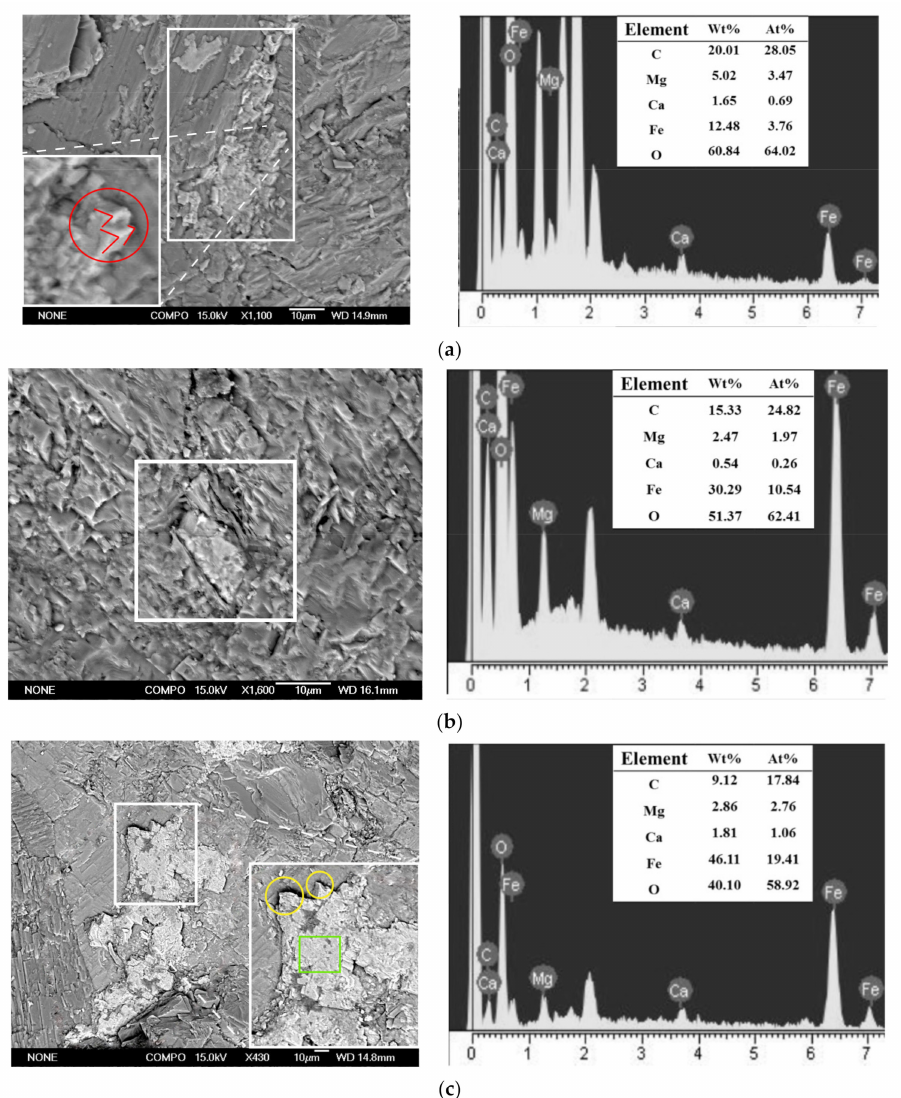
Figure 5. Authigenic carbonates formed after the experiment. ( a ) Carbonates A. ( b ) Carbonates B. ( c ) Carbonates C. Authigenic carbonates (white square); crystal faces (green square); crystal edges (yellow circle); rhombohedral twin (red circle); acute angle of rhombohedron (red